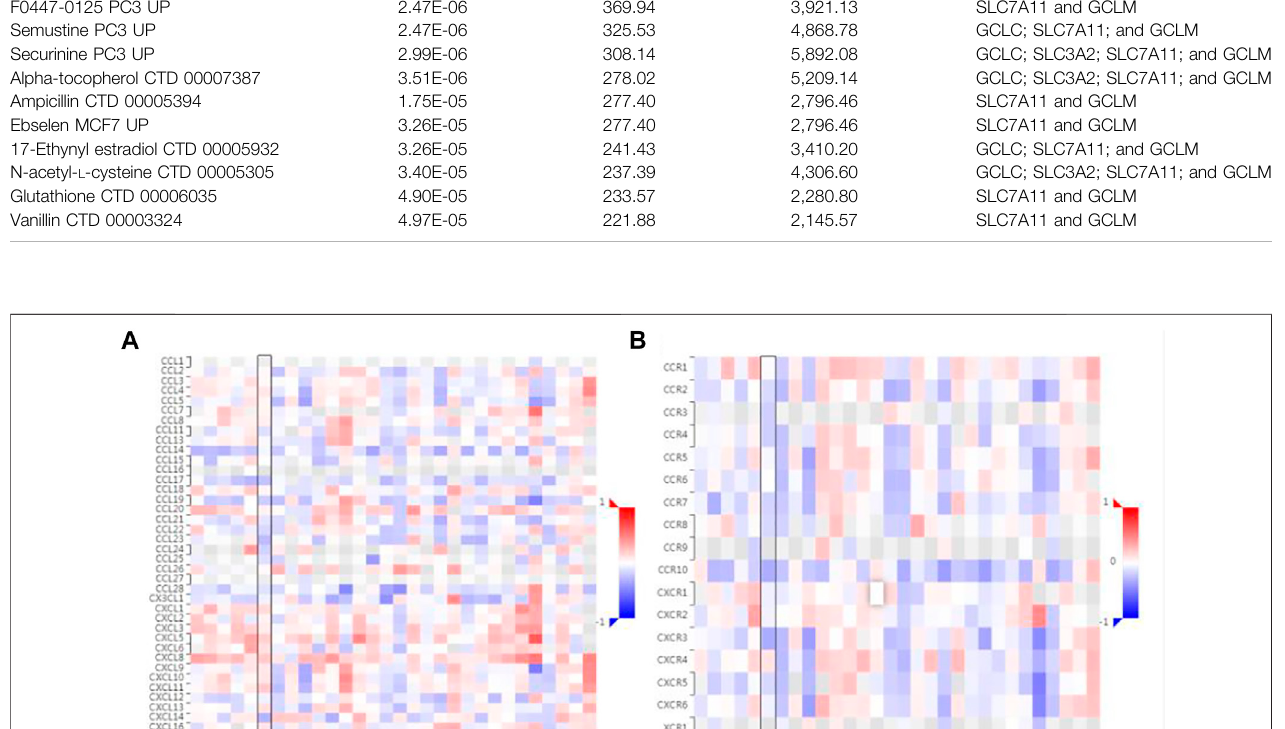
Frontiers in Molecular Biosciences |